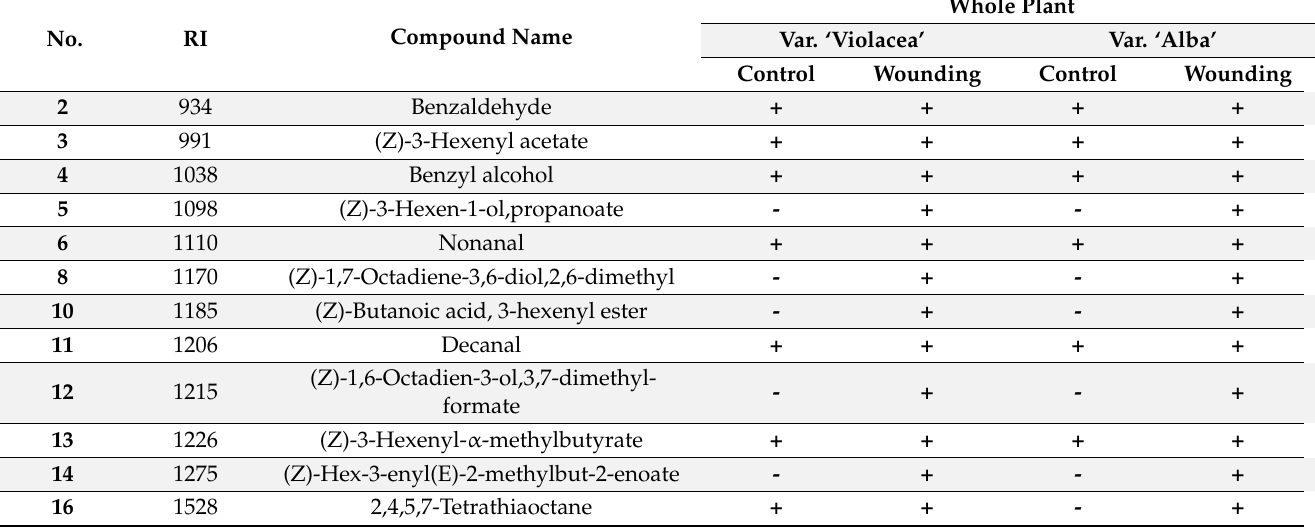
Table 2. VOCs emitted by whole plants of T. violacea and captured by SPME fiber in 5 h wounding indicates that 50% of the leaves were cut at half of their height ( + : presence; - : absence/trace amount). Numbering of volatile compounds respects the order of elution considering the set of compounds identified after the analysis of flowers and of the whole plants (see Table 1) so as to keep the numbering univocal.